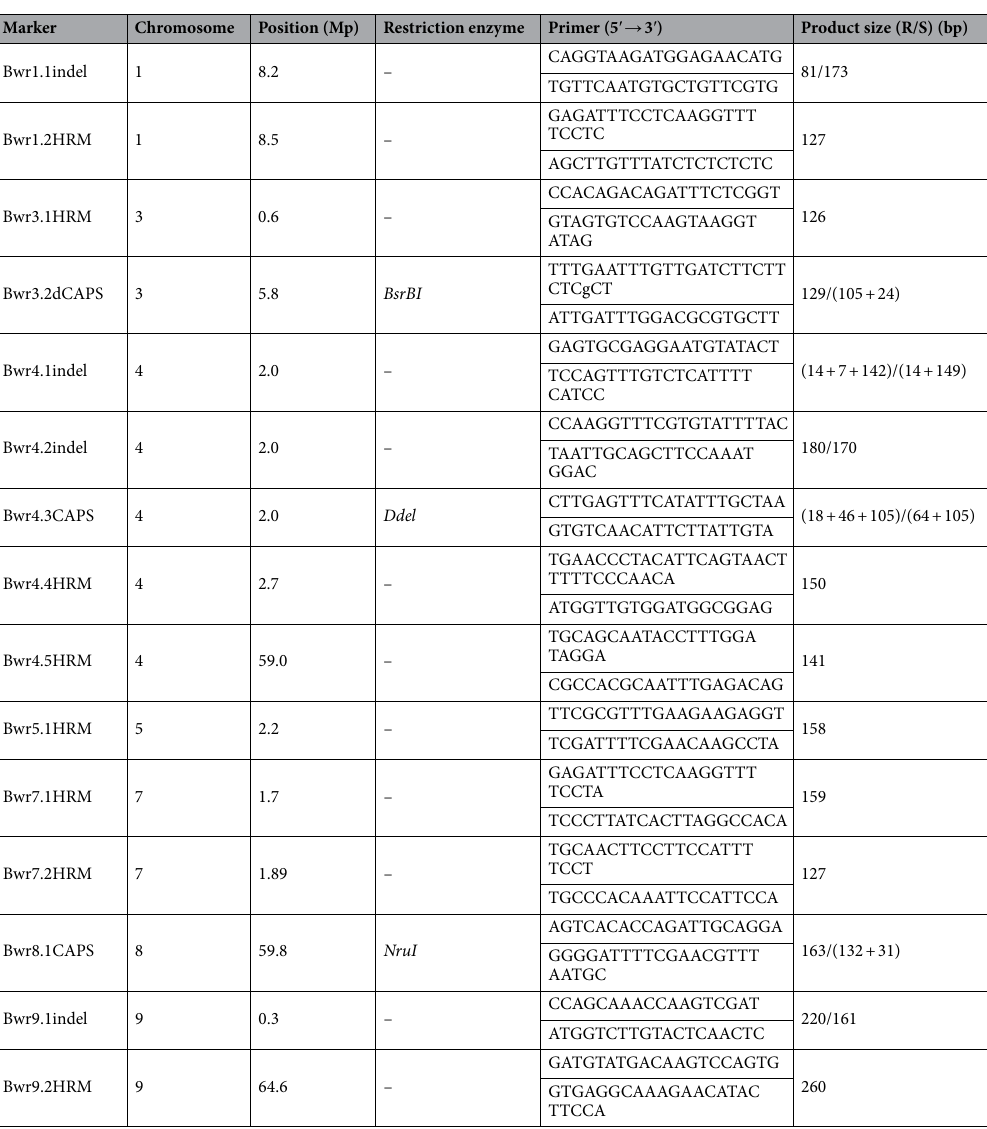
Table 4. Position (Mp), primer sequence, restriction enzyme required, and product size for the molecular markers developed and evaluated in this study for validation in the F 2 populations.